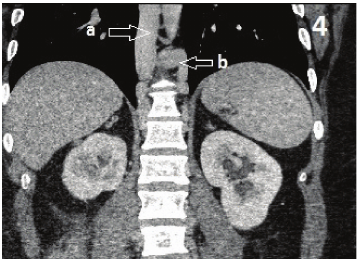
Figure 4: Abdomen CT coronal view: (a) enlarged azygous vein, (b) enlarged hemizygous